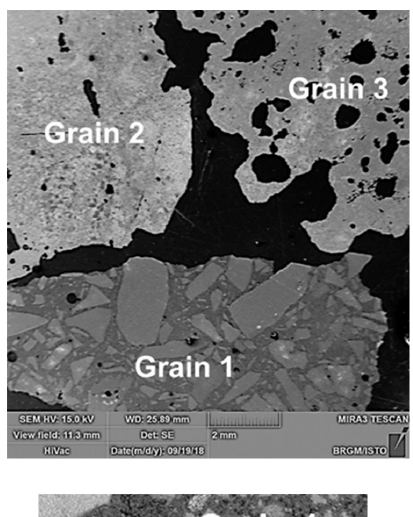
Figure 5. X ‐ ray diffraction (XRD) pattern of EAF slags. Figure 5. X-ray diffraction (XRD) pattern of EAF slags.